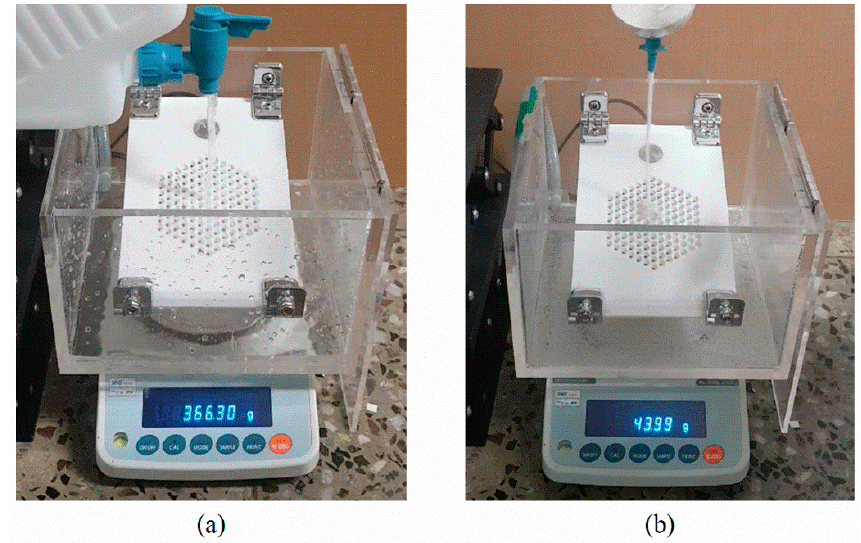
Figure 4. Experimental setup for measuring the vibration of a gauge plate and the mass flow rate of ( a ) running water and ( b ) sands, respectively.